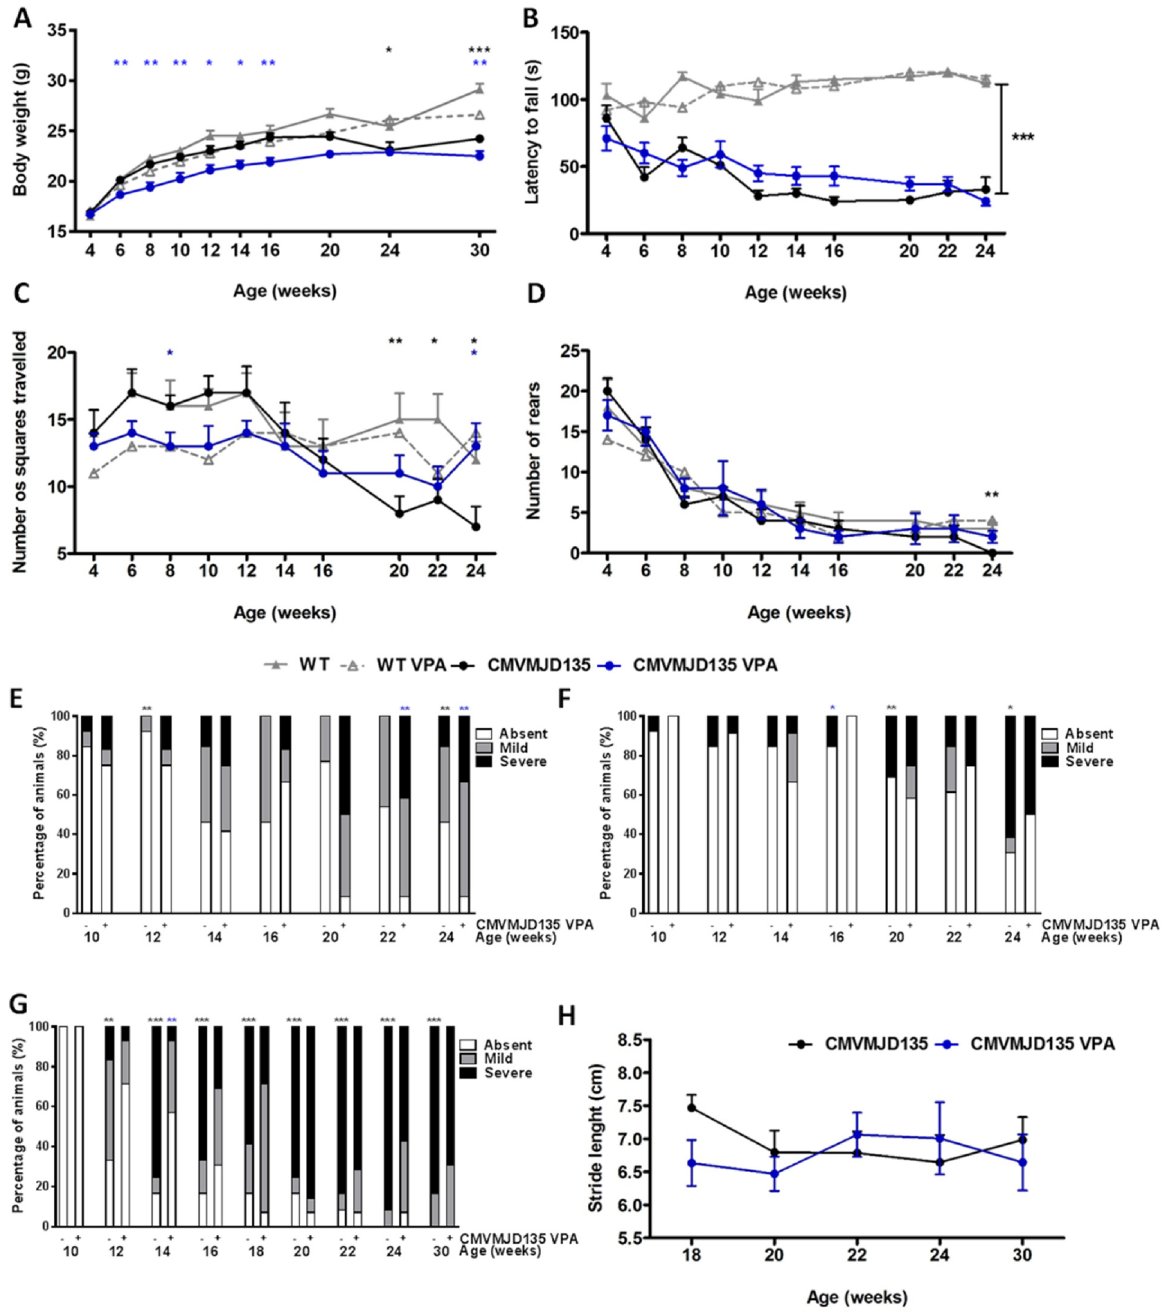
Fig 3. Minor effects in neurological deficits and body weight gain presented by CMVMJD135 mice upon VPA treatment. (A) Decreased body weight gain in CMVMJD135 VPA-treated animals compared to CMVMJD135 vehicle-treated animals; (B) no improvement of VPA-treated animals in grip strength as assessed through the hanging wire test; (C) Improvement in spontaneous locomotor activity at 24 weeks of age; (D,E,F) No improvement in spontaneous activity (vertical movement), in tremors and limb clasping, respectively, (G) transient improvement in footdragging severity at 14 weeks, and (H) tendency toward an improvement in stride length at 22 and 24 weeks of age. Bars represent the mean ± SEM (WT veh, n = 10; WT VPA, n = 15; CMVMJD135 vehicle, n = 10; CMVMJD135 VPA, n = 13), * represent p < 0.05, ** represent p < 0.01 and *** represent p < 0.001, black asterisks represents the difference between WT and CMVMJD135, blue asterisks represents the difference between non-treated and VPA-treated CMVMJD135 (Repeated-measures ANOVA, Tukey correction for continuous variables, One-Way ANOVA for differences between groups in specific ages of the continuous variables and Chi-square Fisher ’ s exact test for categorical non-continuous